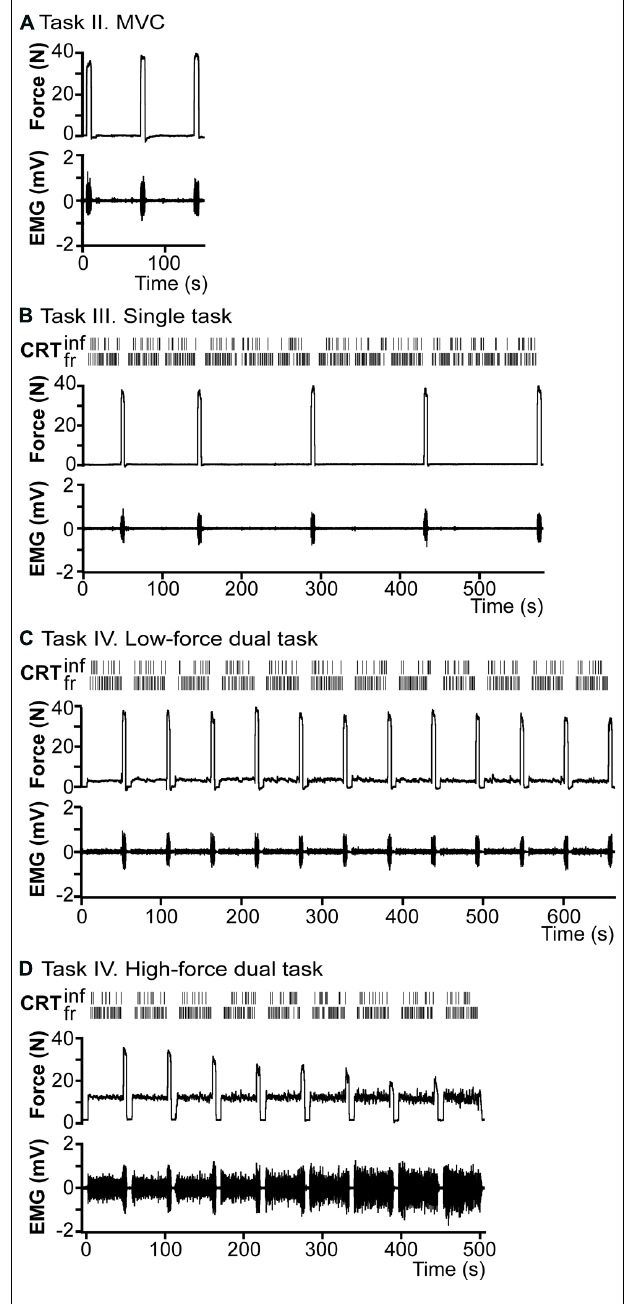
FIGURE 2 | Overview of the raw data of a representative subject. (A) Task II, right index finger abduction force and EMG recordings of the first dorsal interosseus muscle (FDI) during maximal voluntary contractions (MVC). (B) Task III, single CRT-task. Subjects had to respond with either their index or middle finger to two stimuli with a different probability of presentation (frequent and an infrequent tone).Two top rows show the reactions to 12 blocks of CRT, with 5 short (5 s) MVCs between blocks of CRT. Force and EMG recordings are presented in row three and four. (C) Task IV, 10%-dual-task.Top two rows, show 12 blocks of CRT concurrent with right index finger abduction (force and EMG at row three and four) at 10% of cMVC, with a period of 5 s MVC after every block. (D) Task IV. 30%-dual-task. Similar to (C) , but force at 30% of cMVC, the task is maintained until task